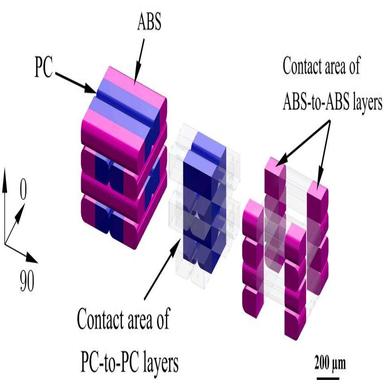
Internal structure of 0/90 layup printed layers with 50 % concentration of PC/ABS materials.